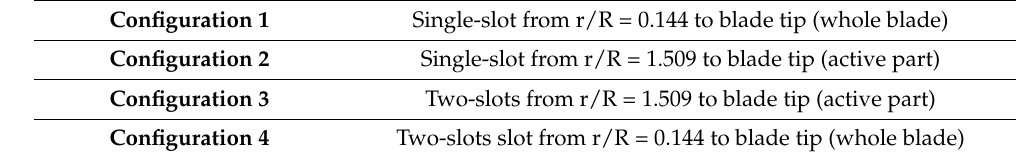
Table 5. Studied configurations.